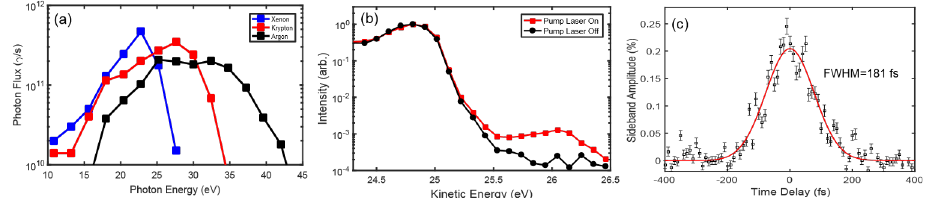
Fig. 1 : (a) Typical photon flux delivered to the sample. A flux greater than 10 11 photons/s in a single harmonic is available from 18 eV to 37.2 eV. (b) LAPE on Au (111) surface with a pump laser with a peak intensity of 1 . 3 × 10 9 W/cm 2 (red) and with the pump laser off (black). (c) LAPE amplitude measured at 26 eV kinetic energy as a function of pump laser-XUV time